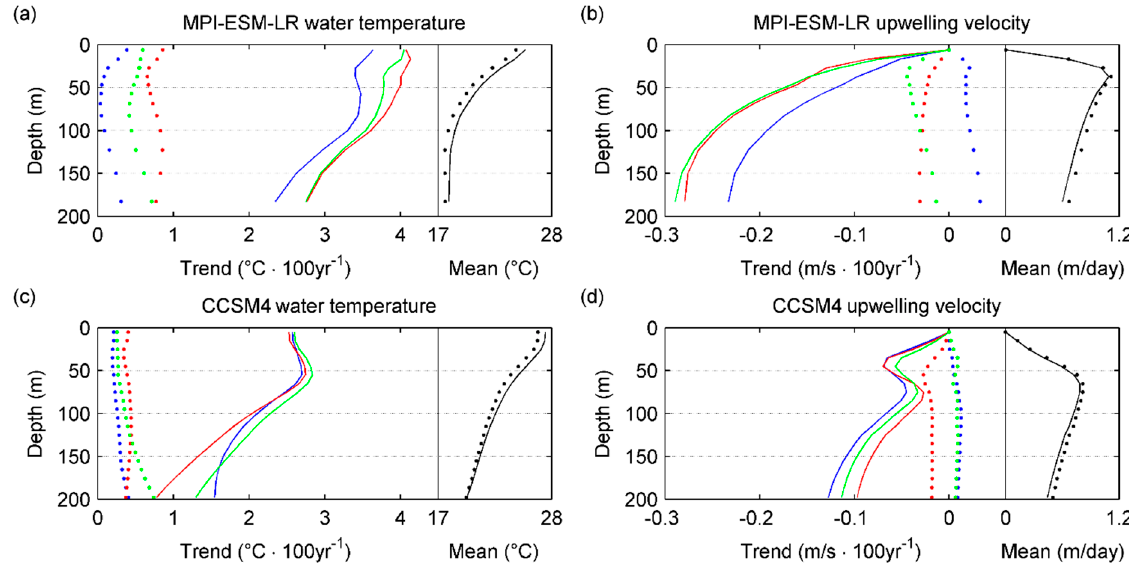
Figure 8. Vertical trends of ( a ) water temperature and ( b ) upwelling velocity in the upper 200 m modeled by MPI-ESM-LR. ( c ) and ( d ) are the same but by CCSM4. Solid lines are the results for the RCP8.5 scenario and dotted lines are for the RCP2.6 scenario. The colored lines show the trends of r1 (blue), r2 (red), and r3 (green) in each model. The black lines on the right of each panel present the mean value of the current variable.